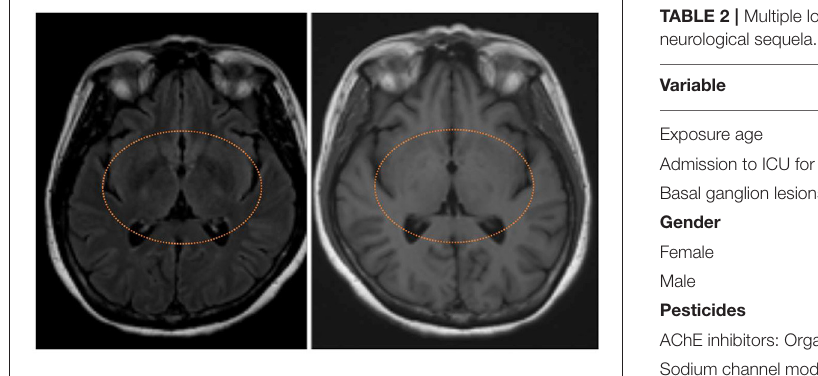
FIGURE 3 | T2 fluid-attenuated inversion recovery magnetic resonance image showing symmetrical hyperintensities in bilateral basal ganglion (left) with T1 hypointensities (right) of neonicotinoids intoxication patient.